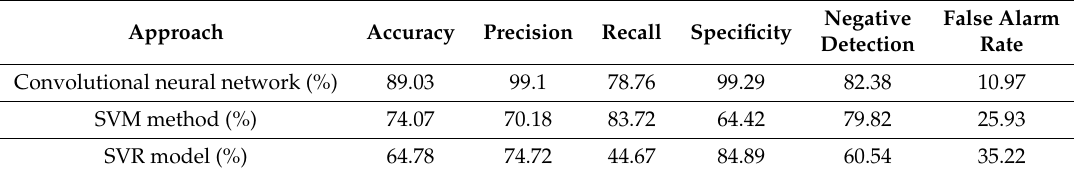
Table 34. Comparison of detection evaluation indices among the three methods for converter faults. Approach